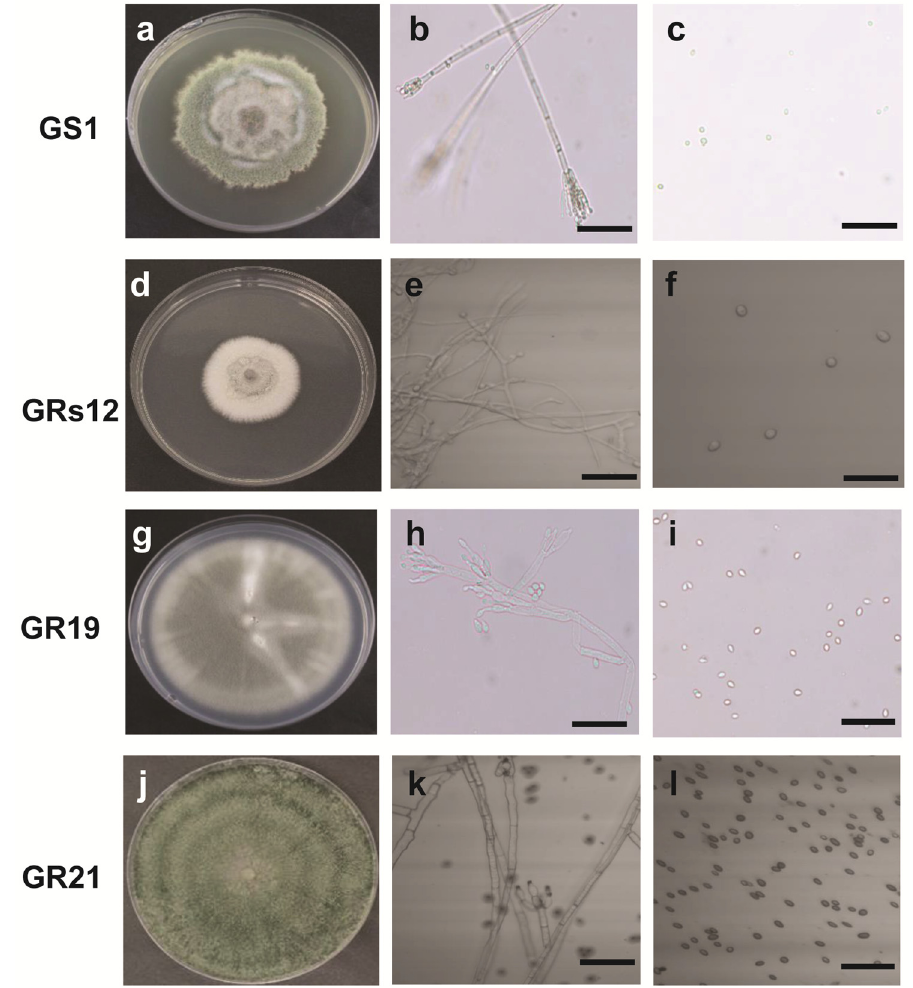
Figure 1. The fungal morphological characteristics of plant growth-promoting fungi in potato dextrose agar at 25 °C after 18 days. ( a ): Colony characteristic of GS1; ( b ): Hyphae morphology of GS1; ( c ): Spore morphology of GS1; ( d ): Colony characteristic of GRs12; ( e ): Hyphae morphology of GRs12; ( f ): Spore morphology of GRs12; ( g ): Colony characteristic of GR19; ( h ): Hyphae morphology of GR19; ( i ): Spore morphology of GR19; ( j ): Colony characteristic of GR21; ( k ): Hyphae morphology of GR21; ( l ): Spore morphology of GR21. The bar represented 25 μ m.